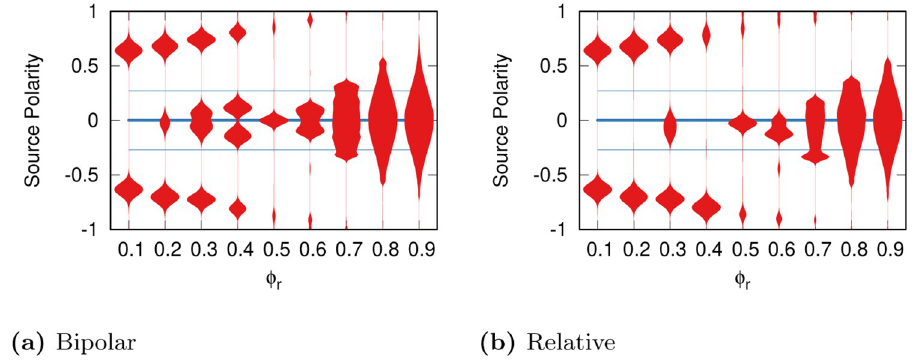
(x axis). The thick and thin blue lines represent the initial average polarity mean and standard r deviation of the sources before gradient descent, respectively.